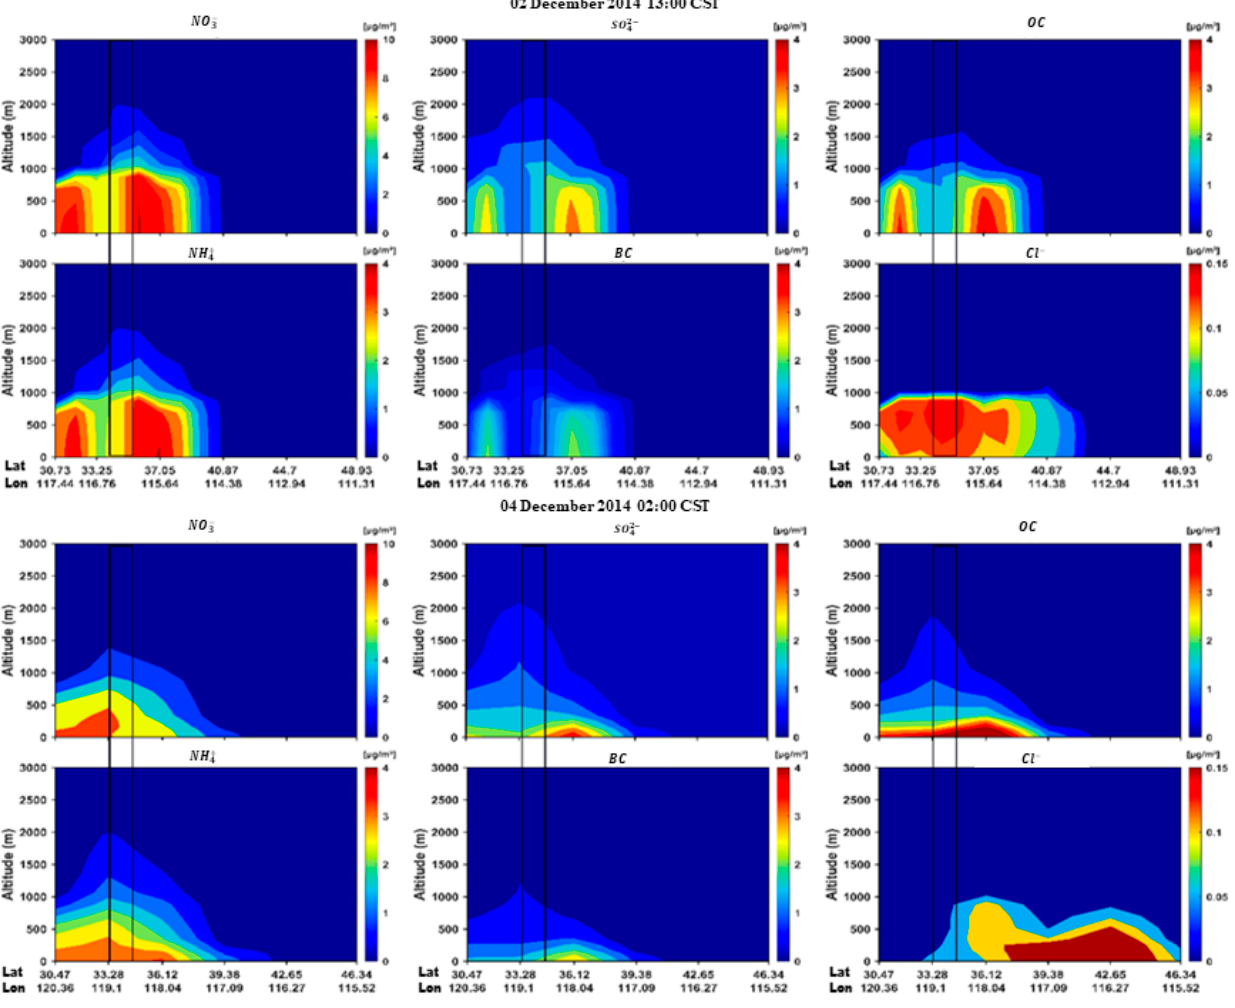
Figure 6. Vertical sections of the main components of PM 2.5 along the trajectory of CALIPSO on 2 December and 4 December 2014 (China Standard Time (CST)). The black box represents the scope of Xuzhou.